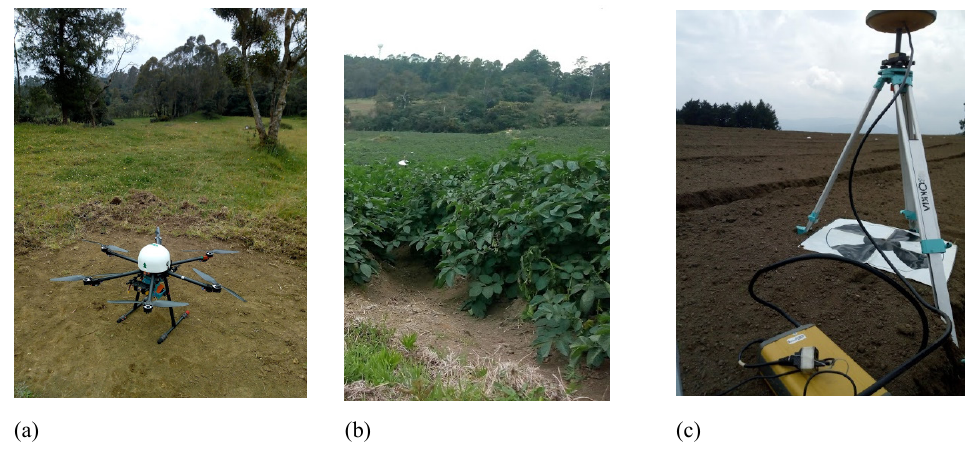
Figure 3. UAV flight over the study plots of pasture, potatoes, and bare soil. ( a ) UAV hexacopter on the pasture study plot, ( b ) potatoes study site, ( c ) Topcon submetric device on bare soil study site. Simultaneously with the ground measurement, aerial images were acquired using a hexacopter UAV and a multispectral RedEdge camera, Micasense©, Seattle, WA, USA obtaining multiple sets of images in five spectral bands, blue (475 nm), green (560 nm), red (668 nm), red edge (717 nm) from the visible rank, and NIR (840 nm), to determine soil moisture reflectance (Figure 4). UgCS software, Riga, Latvia, Europe, was used for the automated drone mission planning. The images were later merged and postprocessed in the laboratory for geometric correction and calibration using the Pix4D© software, Prilly, Switzerland, Europe. Radiometric correction of the images PlanetScope©, San Francisco, CA, USA was carried out by means of the Qgis software, Gossau, Switzerland, Europe and the required parameters were obtained from the image metadata.